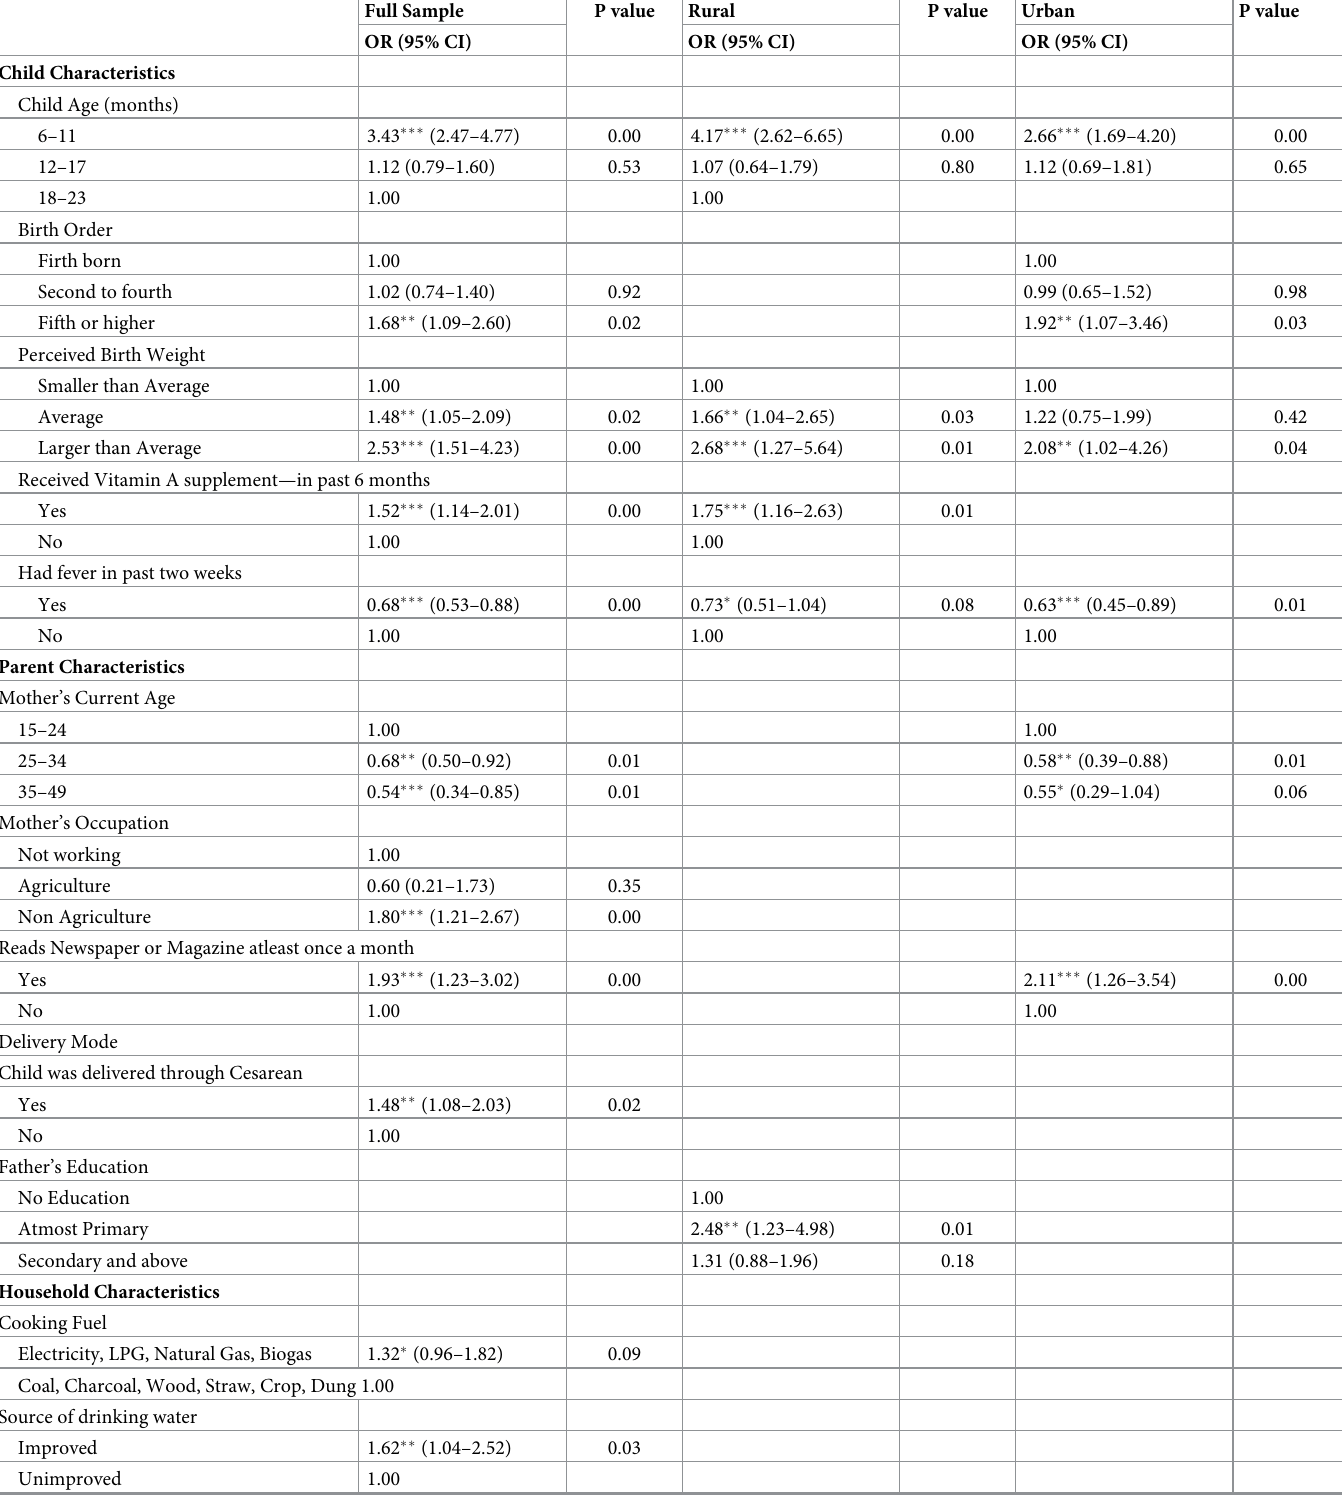
Table 5. Significant correlates (OR (95% CI)) of minimum acceptable diet as per WHO recommendations using multivariate logistic